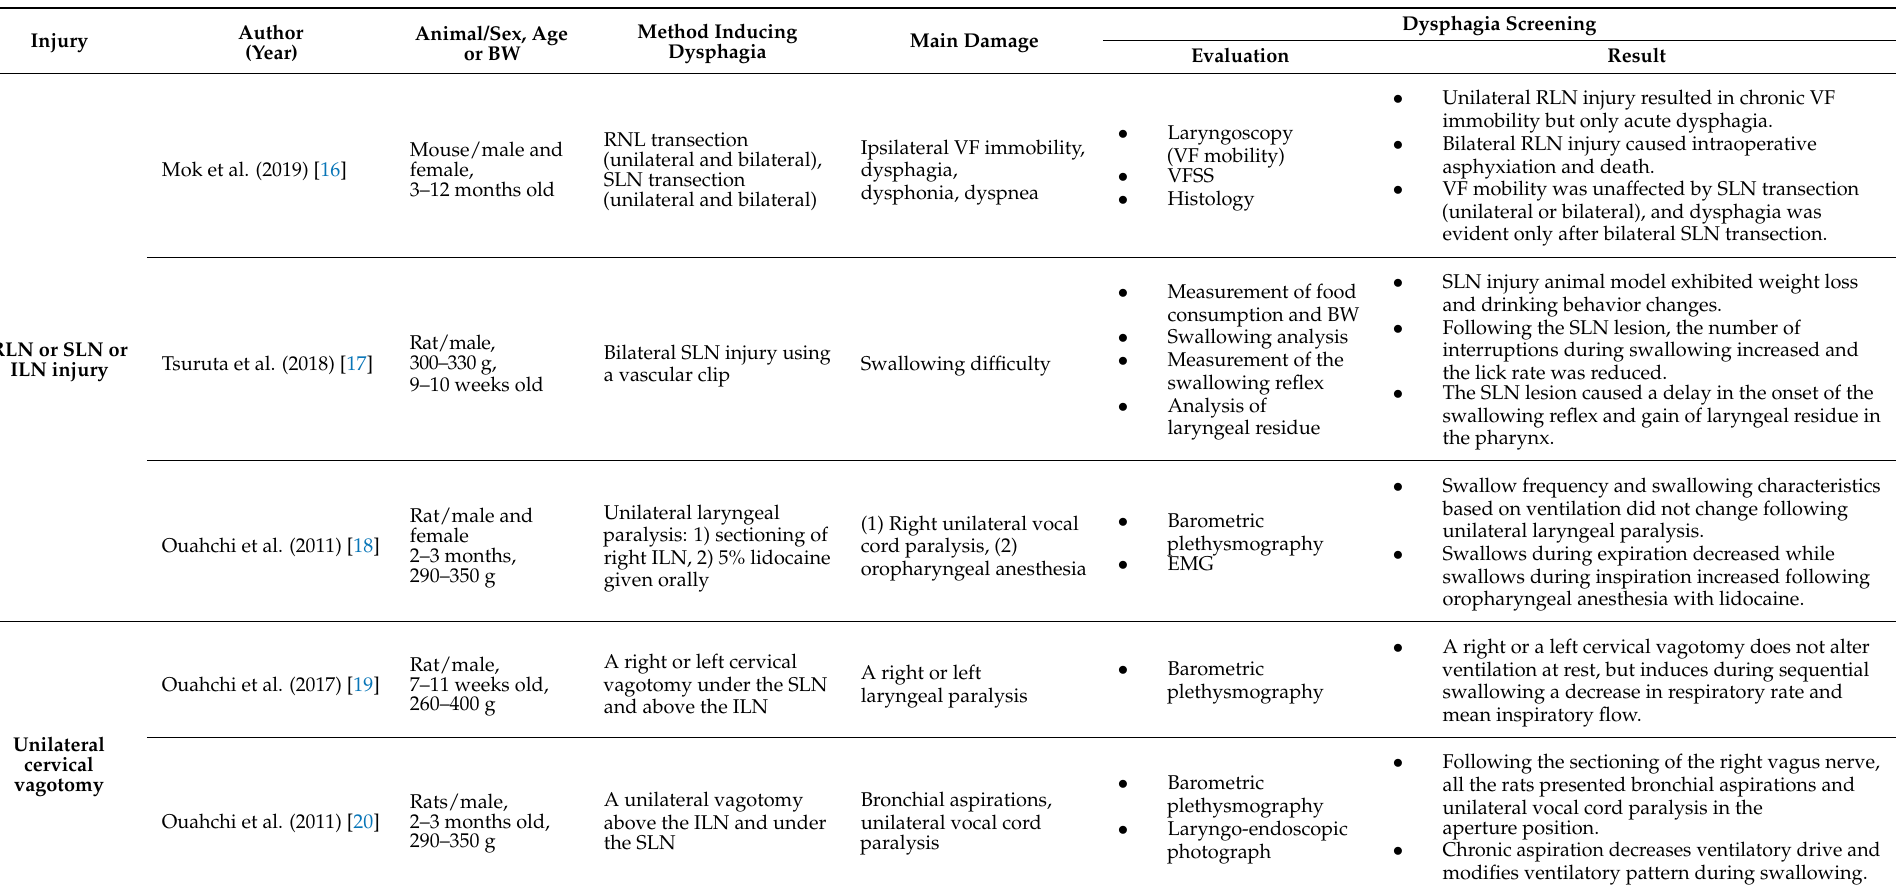
Table 2. Characterization of oropharyngeal dysphagia in rodent models of laryngeal